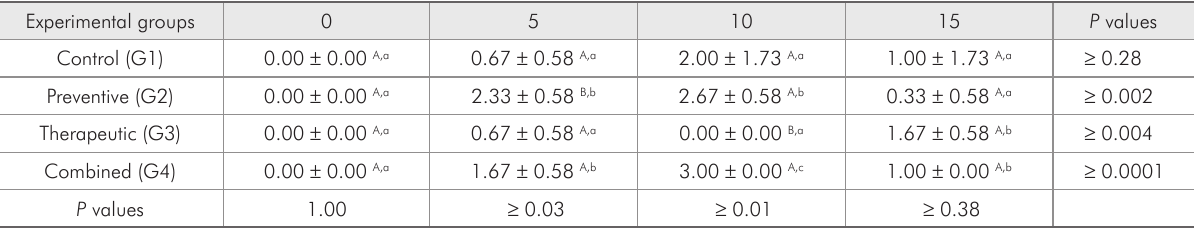
Table 3 - Mean ± standard deviation of histopathological scores of animals in different groups at different evaluation times